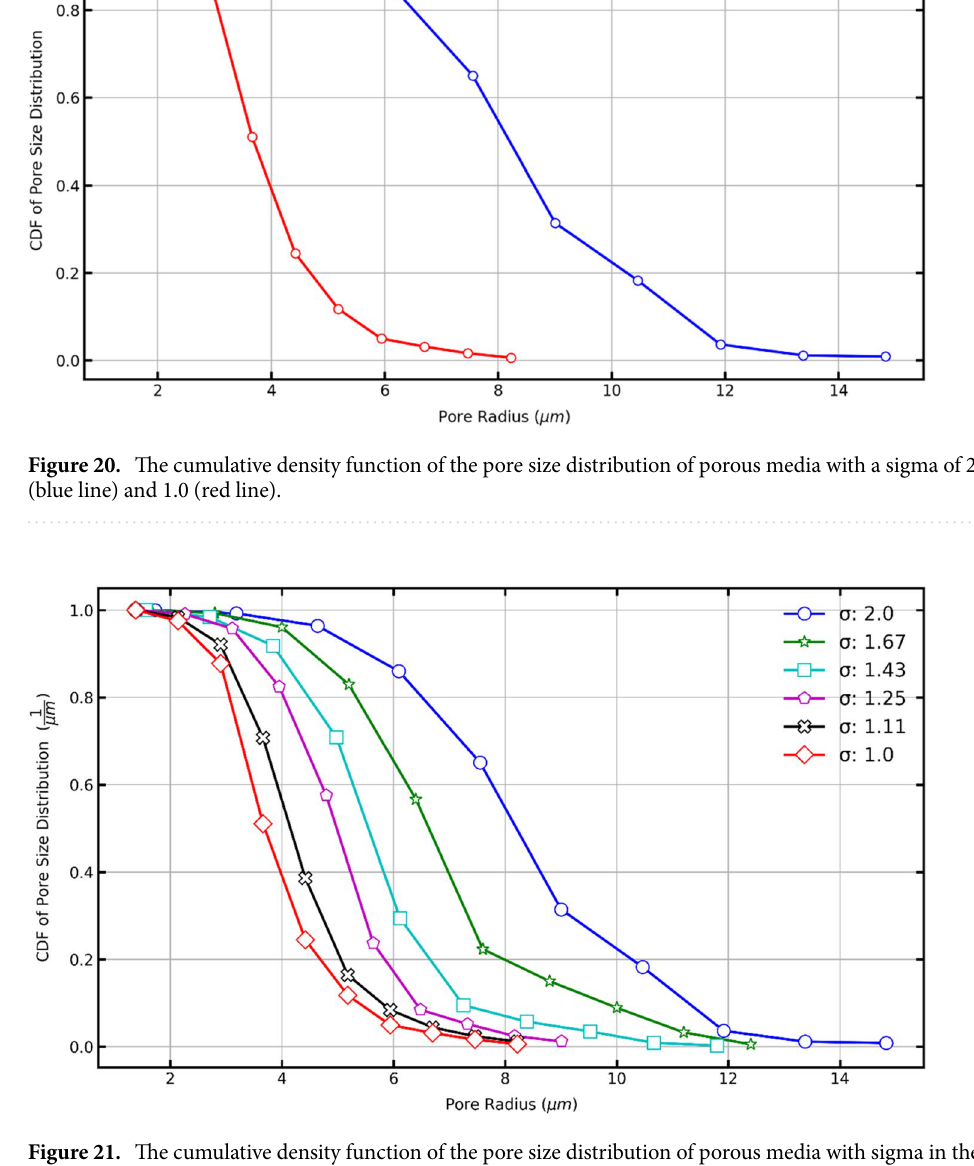
Figure 21. The cumulative density function of the pore size distribution of porous media with sigma in the range